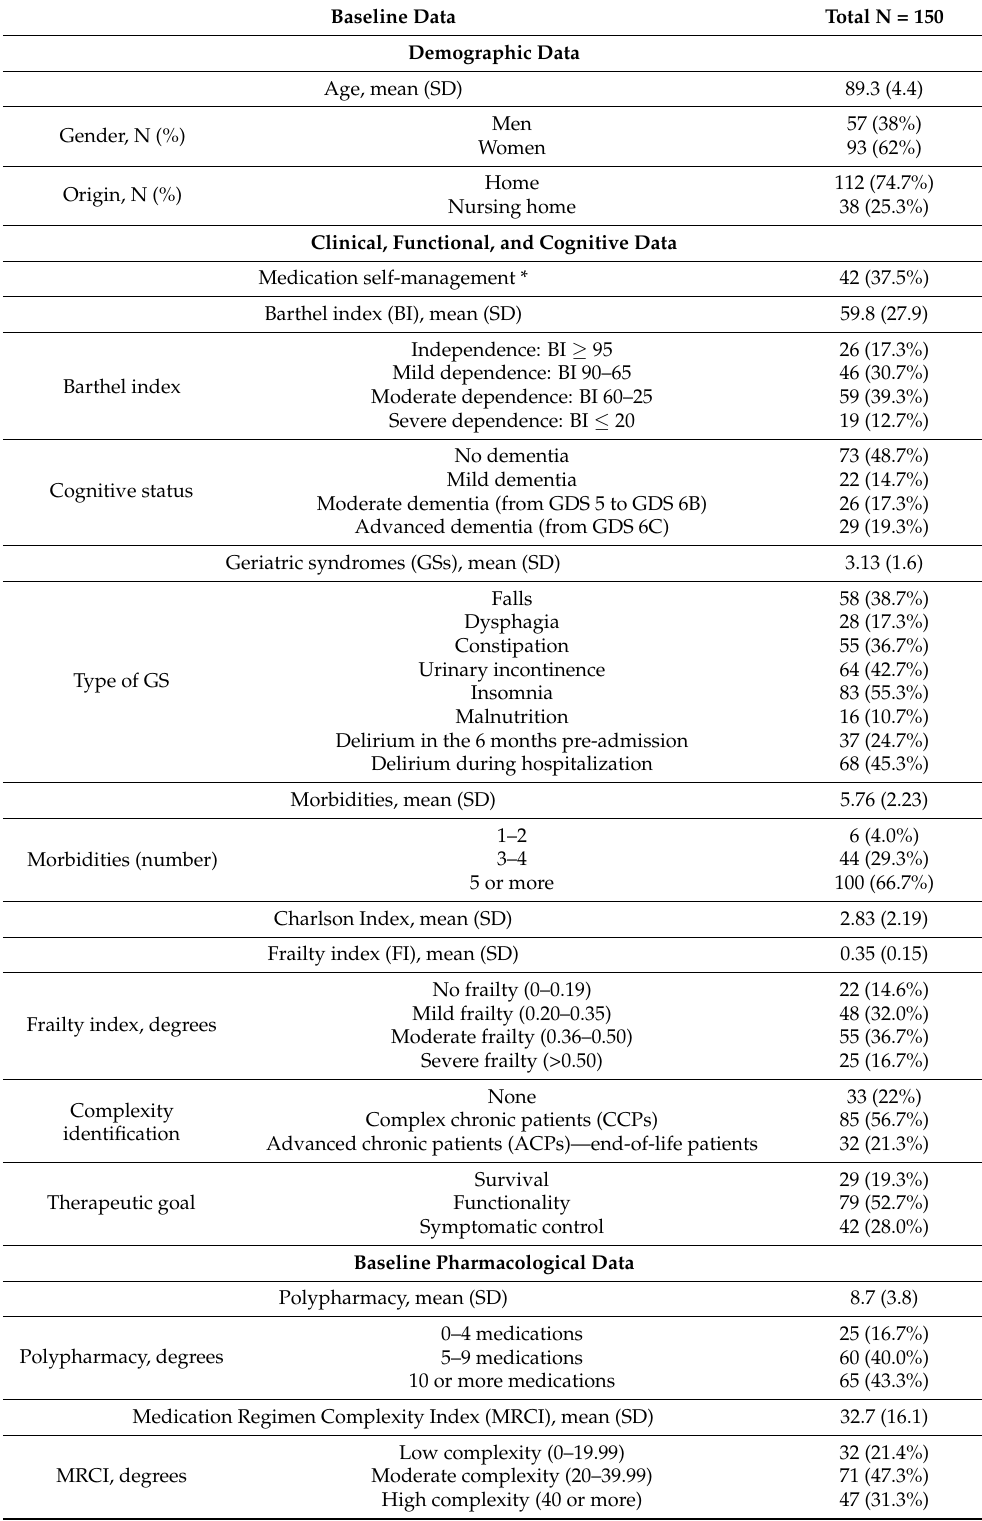
Table 1. Patients’ baseline